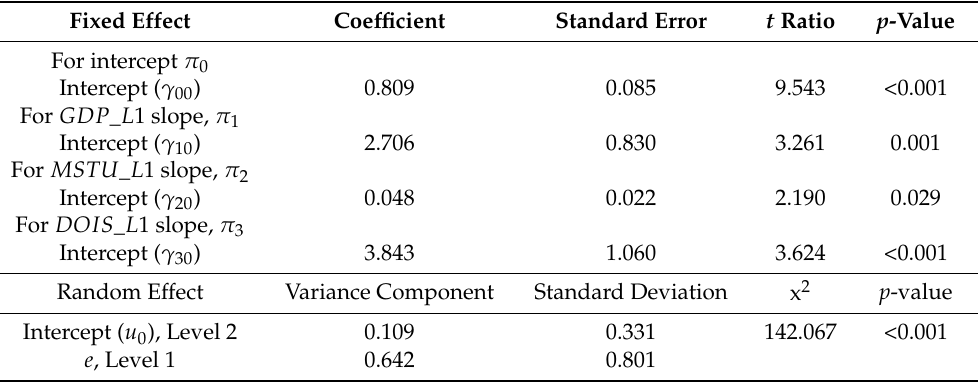
Table 4. Results of the parameter, random intercept, and fixed slope models of fire occurrence